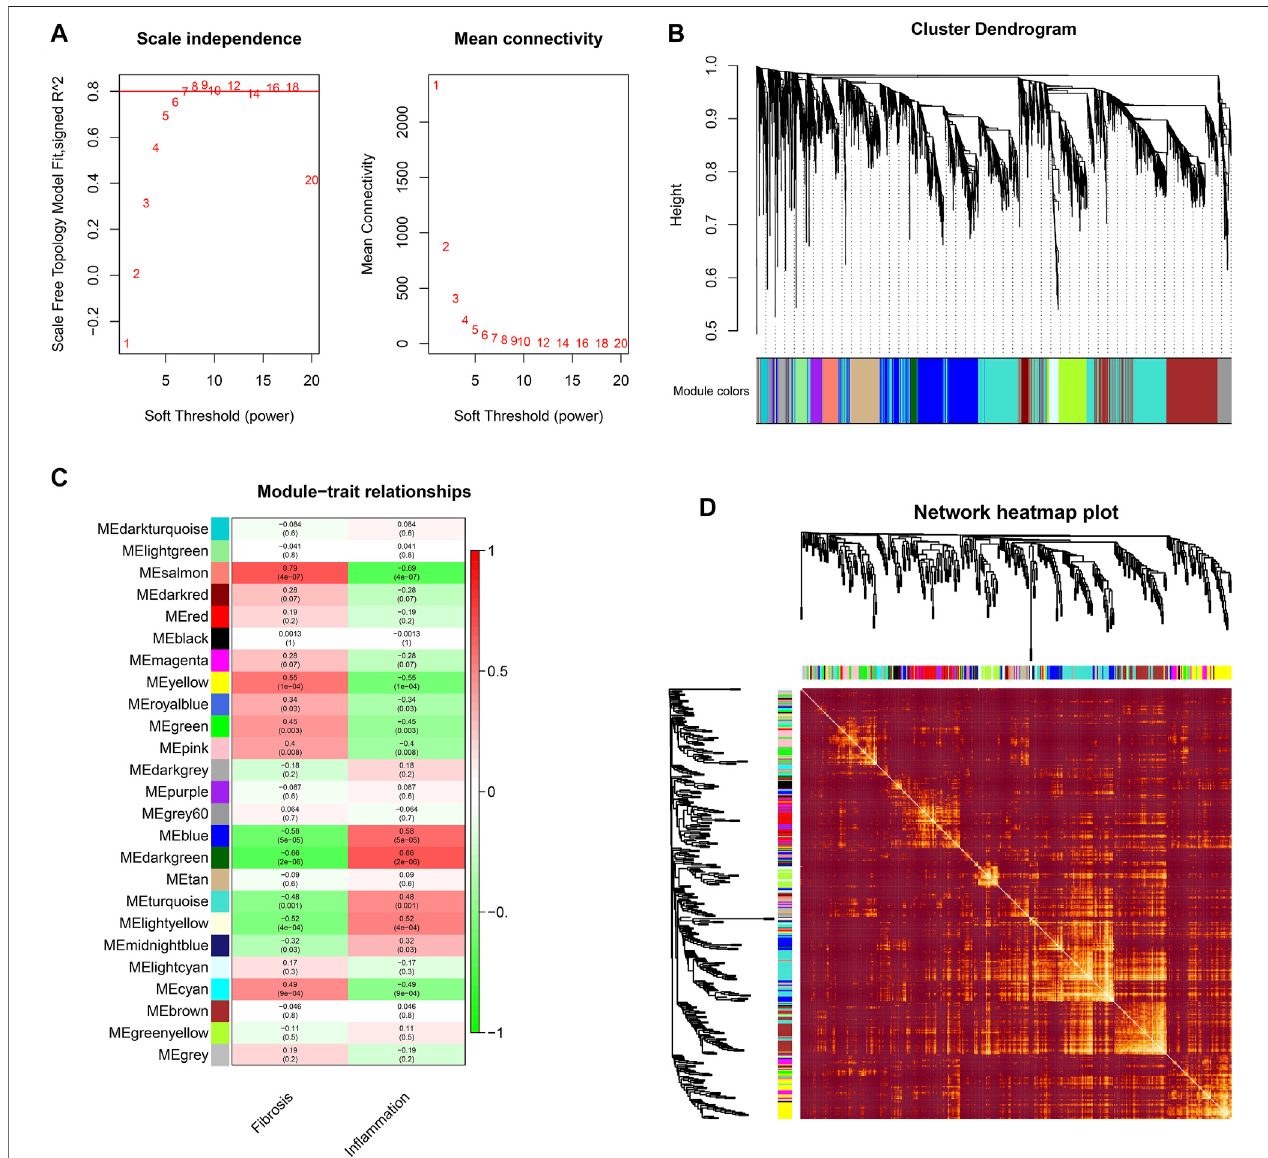
FIGURE 1 | Construction of co-expression modules (A) Determination of soft-threshold power (B) The cluster dendrogram of genes (C) Heatmap of the module- trait relationships (D) Network heatmap plots of genes selected for WGCNA construction.